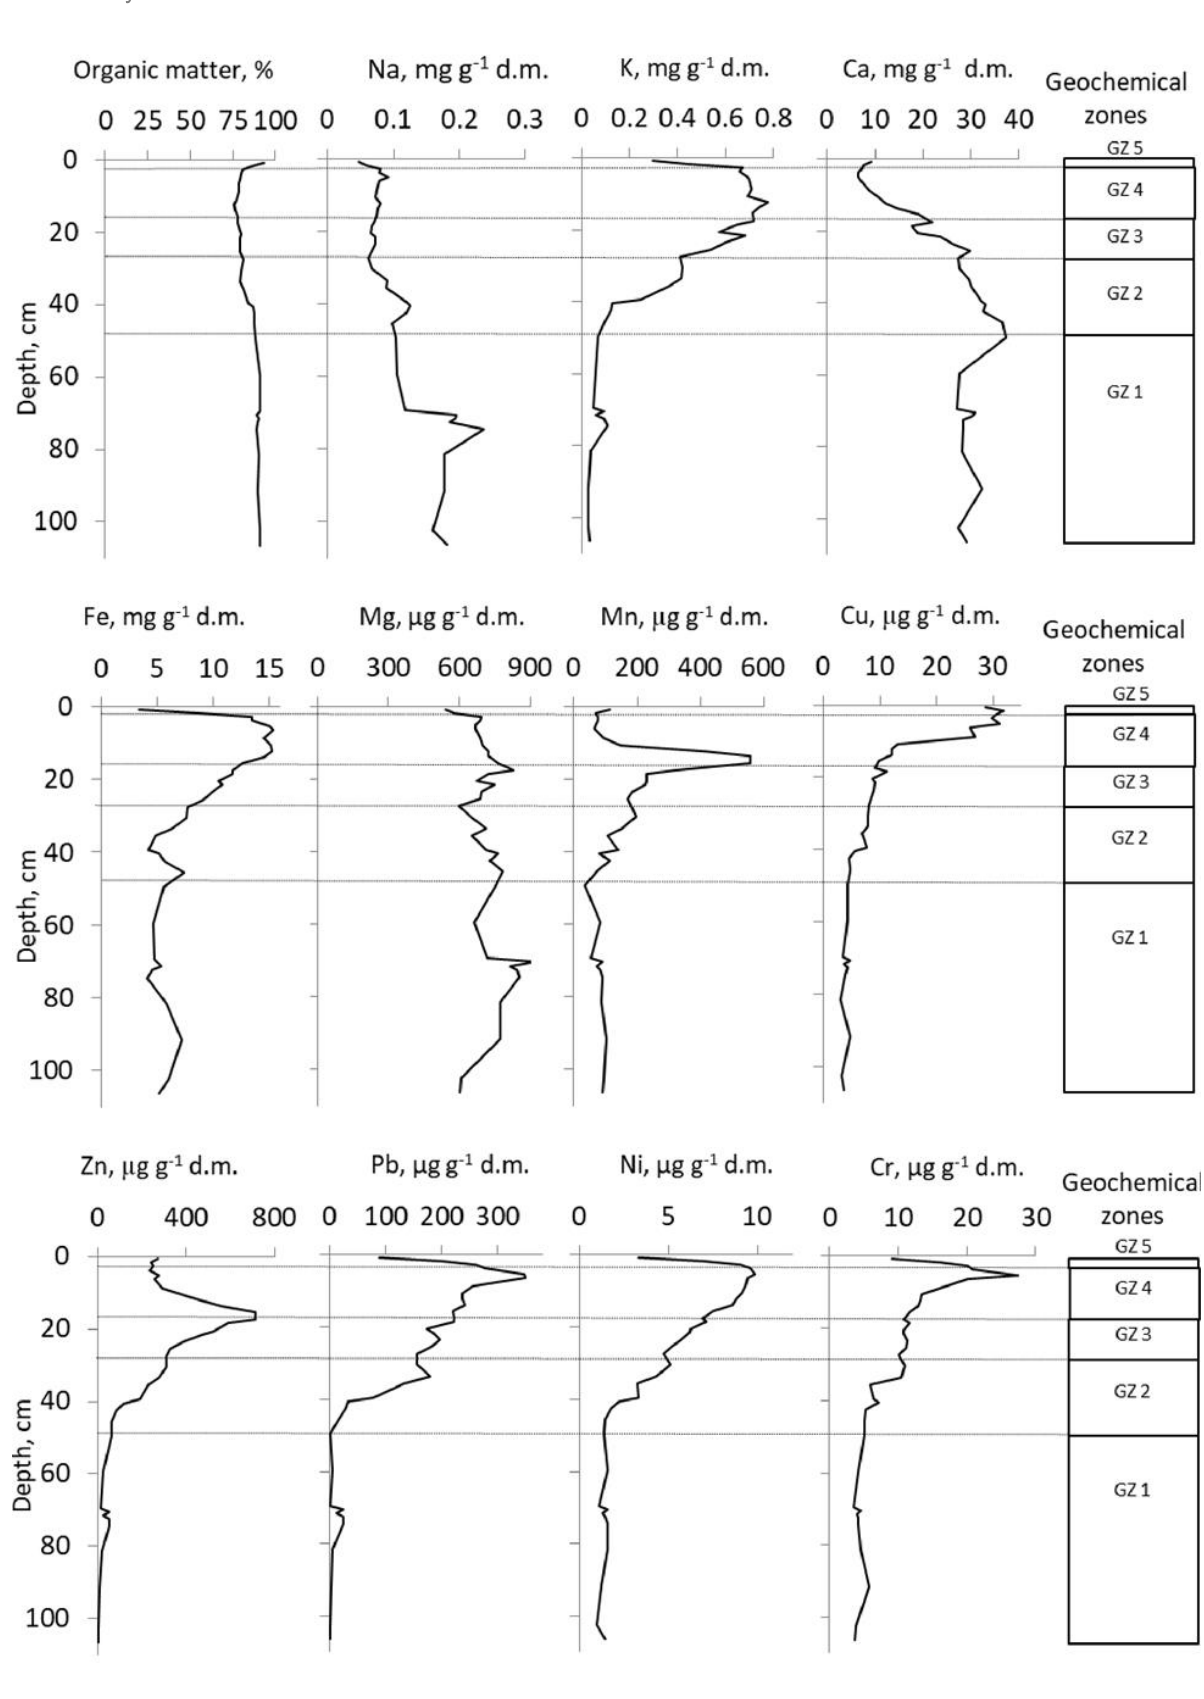
Figure 2. Concentrations of selected major and trace elements in Core W3, obtained by AAS analysis; d.m. = dry